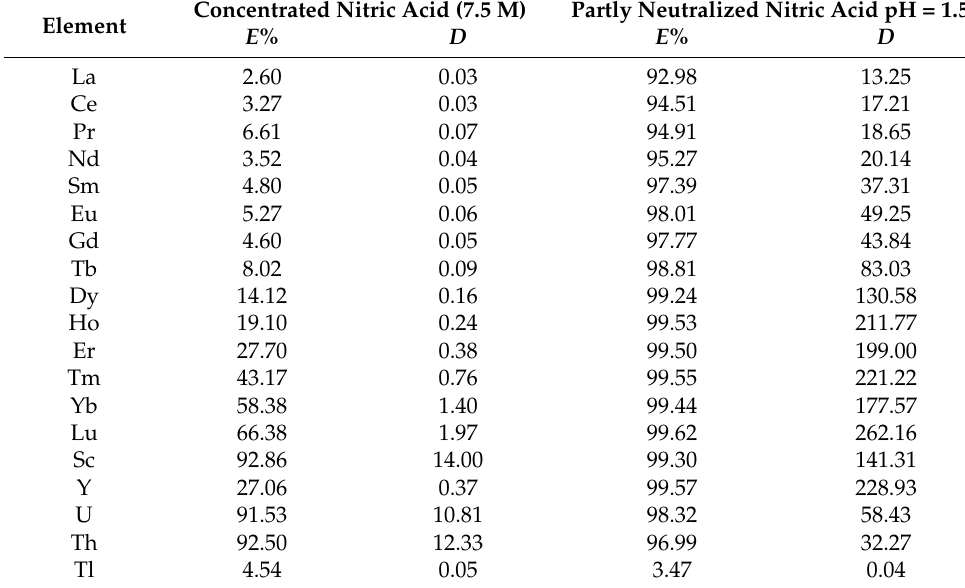
Table 3. Extraction efficiency (E in %), distribution ratio (D) of REE, Sc, Y, U, Th, and Tl in